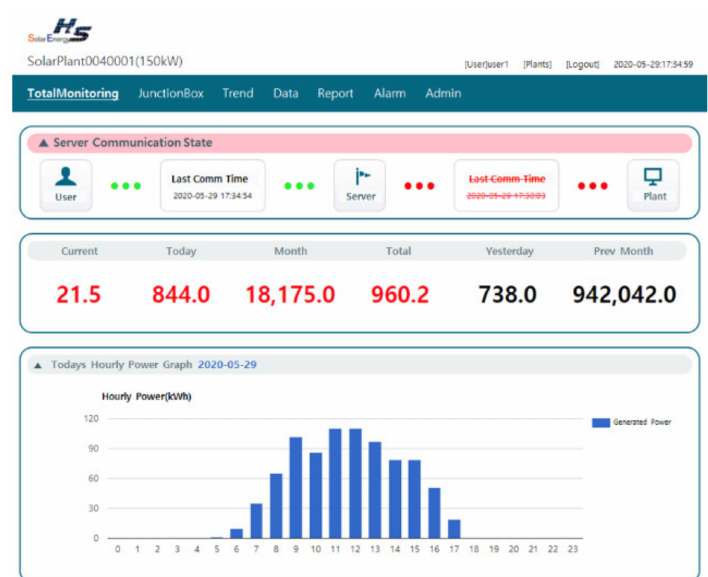
Figure 5. Implemented M-PVMS monitoring server.